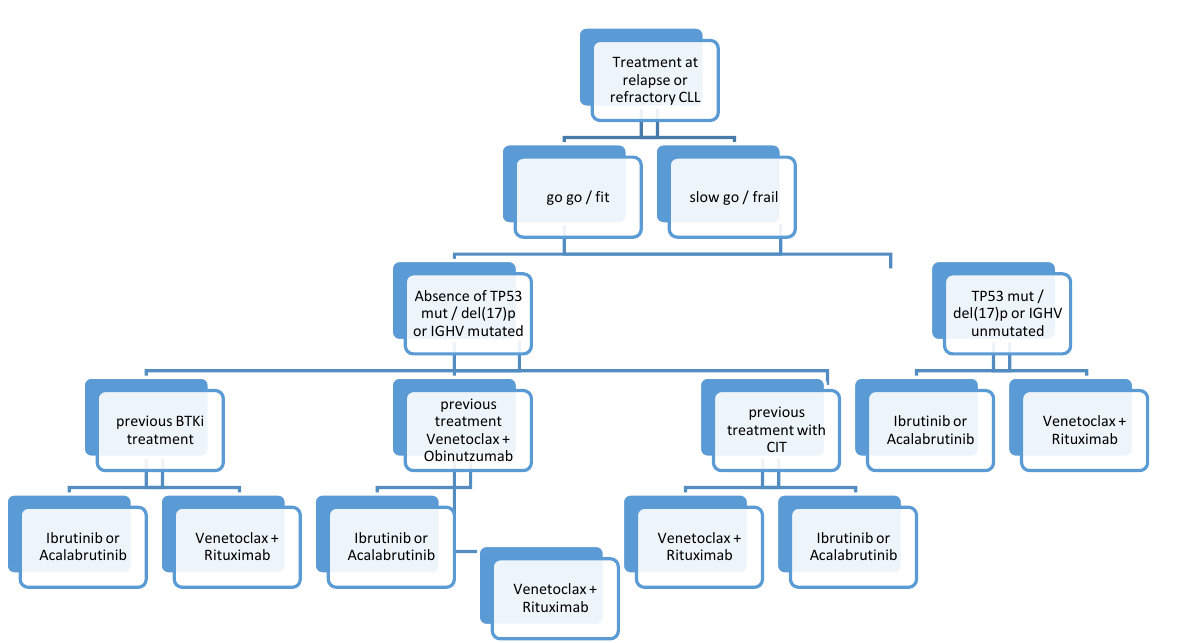
Figure 2. Treatment algorithm in relapsed/refractory CLL.